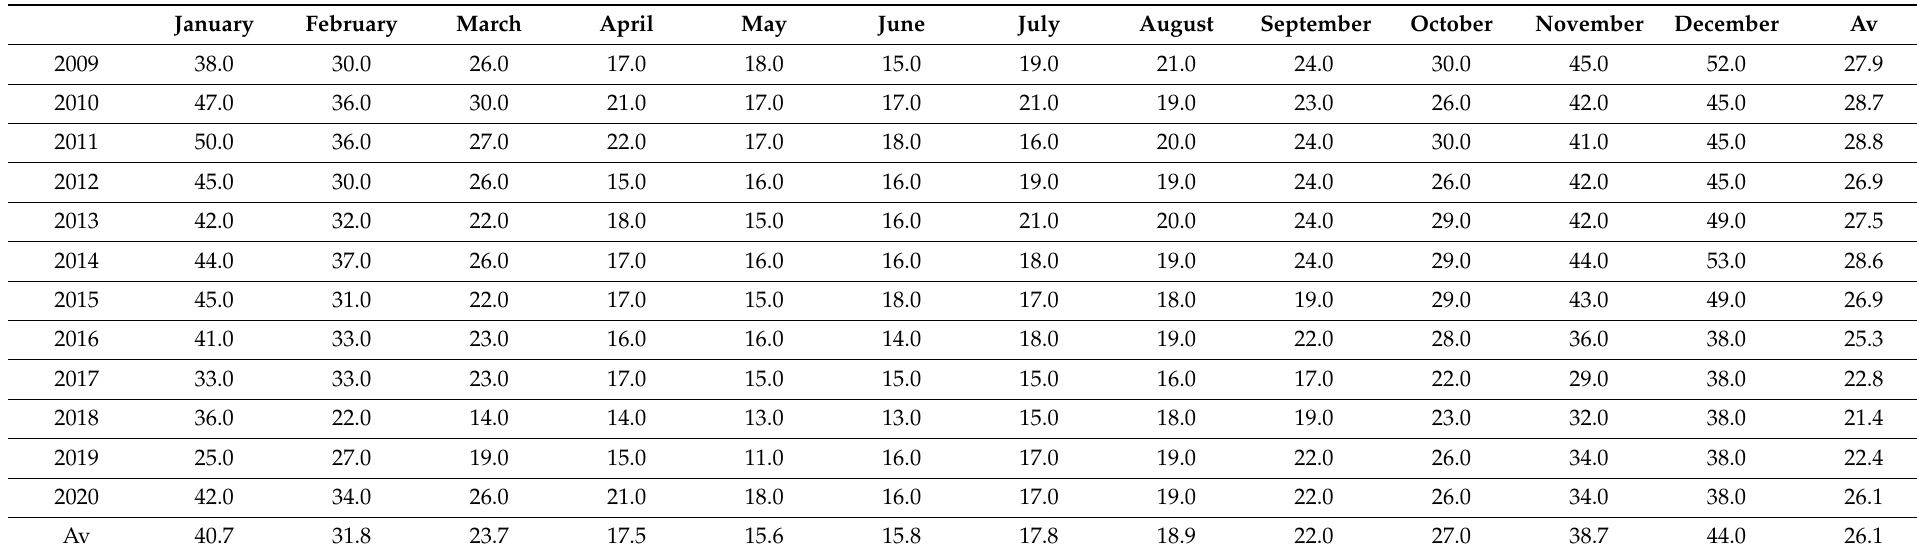
Table 3. Monthly relative humidity (%) at Lake Nasser during the period from 2009 to